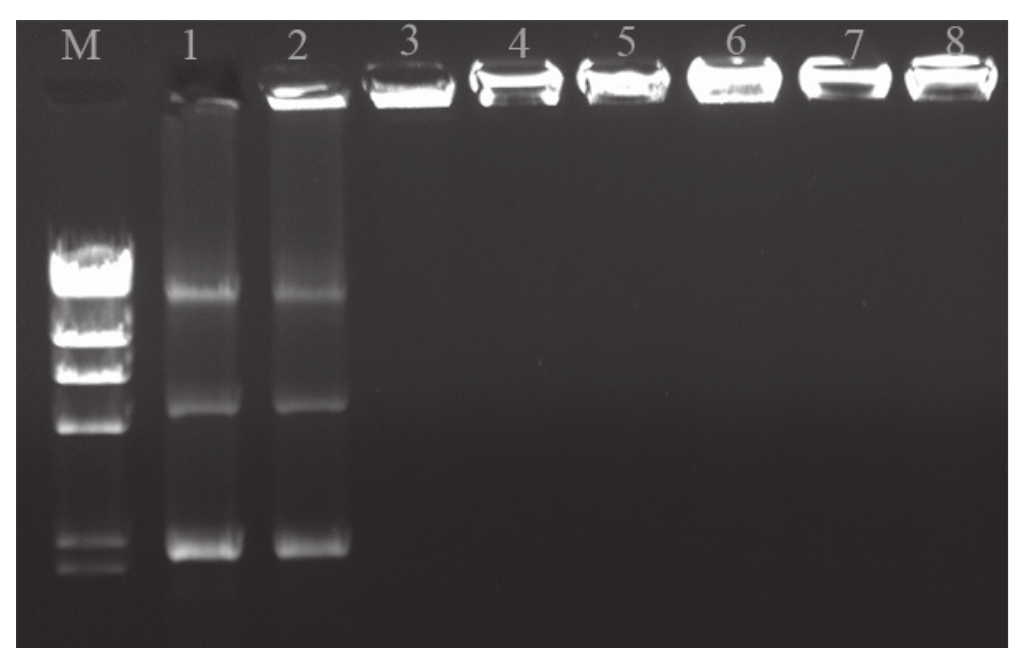
FIGURE 1 - Gel retarding analysis of chitosan/pGM-CSF complexes. λDNA Hind III Marker, Lane 1. Free pGM-CSF; lane 2-8. Chitosan/pDNA complexes at weight ratios of 0.05/1, 0.1/1, 0.5/1, 1/1, 2/1, 5/1, 10/1,